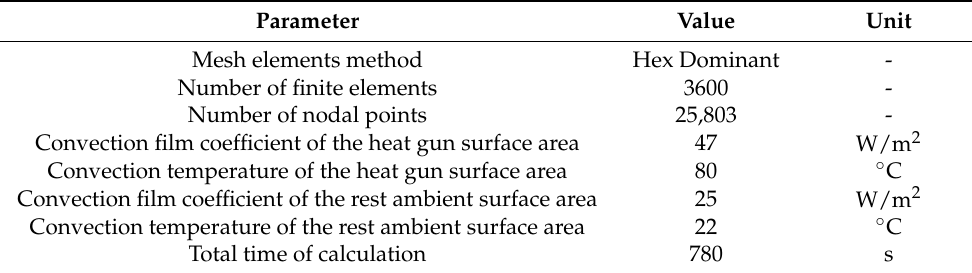
Table 2. FE numerical simulation data of the first stage of analysis.